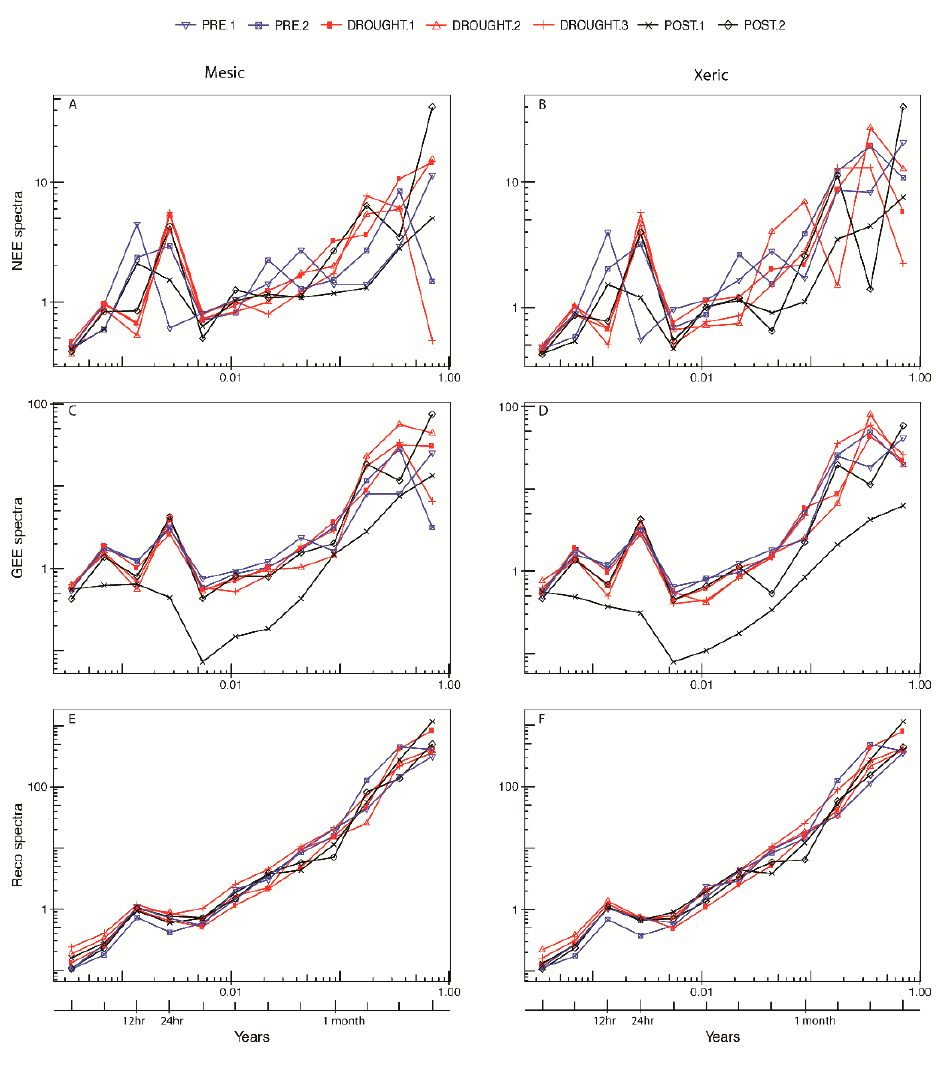
Figure 5. Mesic versus xeric normalized wavelet spectra of net ecosystem exchange of CO 2 (NEE; ( A , B )), gross ecosystem exchange (GEE; ( C , D )), and ecosystem respiration (R eco ; ( E , F )). The graphs show variance of the time-series signal at each respective time-scale.